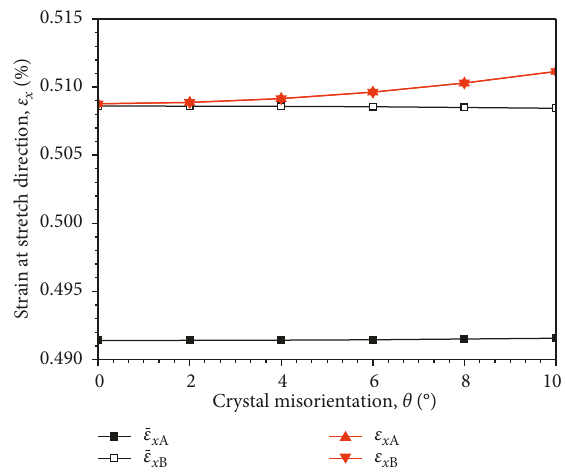
Figure 10: Strain state of each grain for type I bicrystals.